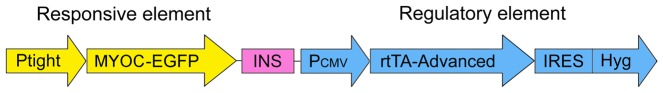
Single plasmid construct with two expression cassettes.The two cassettes (responsive element, in yellow, and regulatory element, in blue) are separated by 5′-HS4 chicken β-globin insulator (INS, in pink).